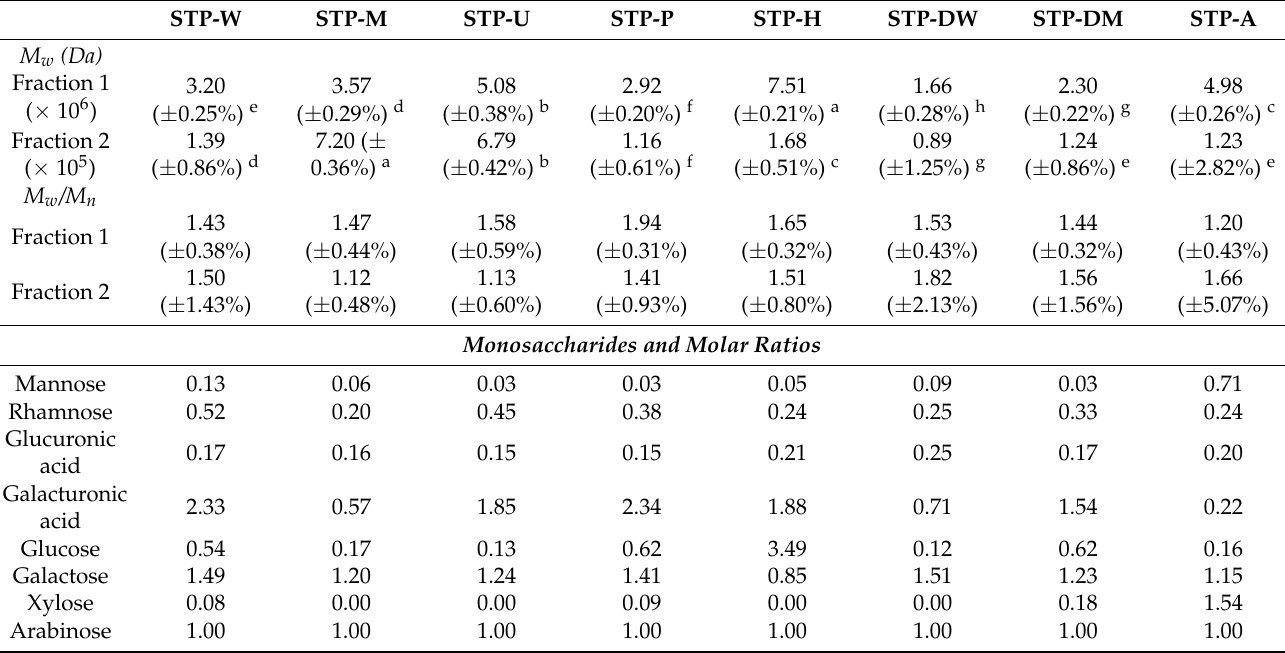
Table 2. Molecular weight ( M w ), polydispersity ( M w /M n ), and molar ratios of compositional monosaccharides of